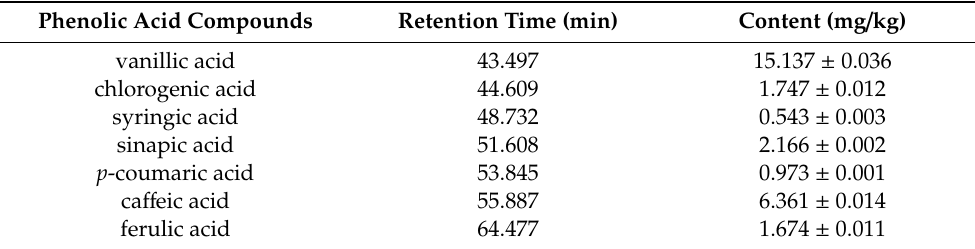
Table 2. The concentrations of the major phenolic acid compounds in the vinasse